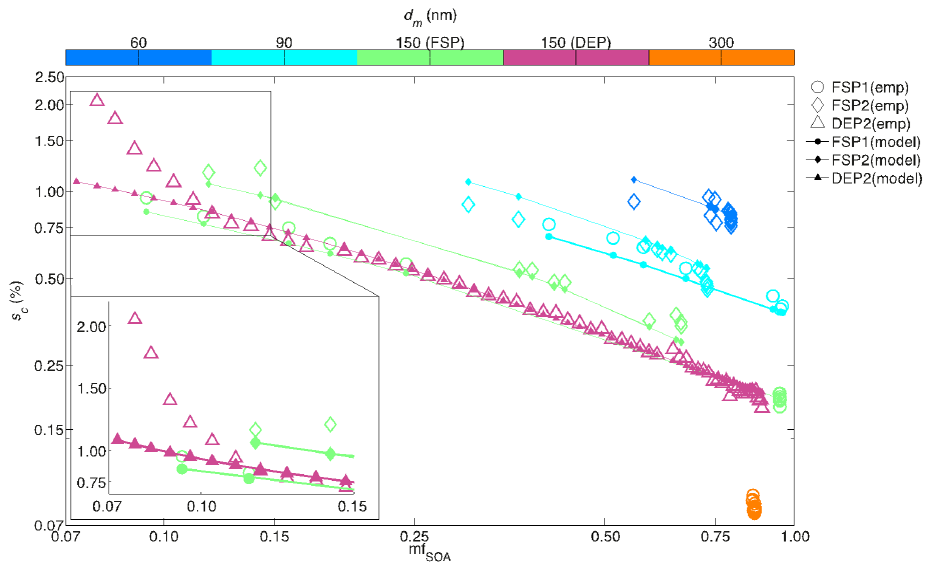
Figure 11. Measured critical supersaturation ( s c ) by estimated mass fraction SOA (mf SOA ) , for experiments FSP1 (circles), FSP2 (diamonds) and DEP2 (triangles). Also shown are κ -Köhler modelled results using d ve , fit as input for d s (filled markers/lines). The measured mobility diameter of the particles are colour coded, separating only the FSP from DEP measurements for d m = 150nm ( d m = 60nm, dark blue; d m = 90nm, light blue; d m , FSP = 150nm, green; d m , DEP = 150nm, pink; d m = 300nm, orange). The measurements are well represented by the model for mf SOA >0.12. For lower organic fraction the particle properties are hindering the activation into cloud droplets, i.e. a higher supersaturation is needed for activation. Also, the model is not as representative for FSP2, d m = 90 and 150nm (green diamonds), as for the other